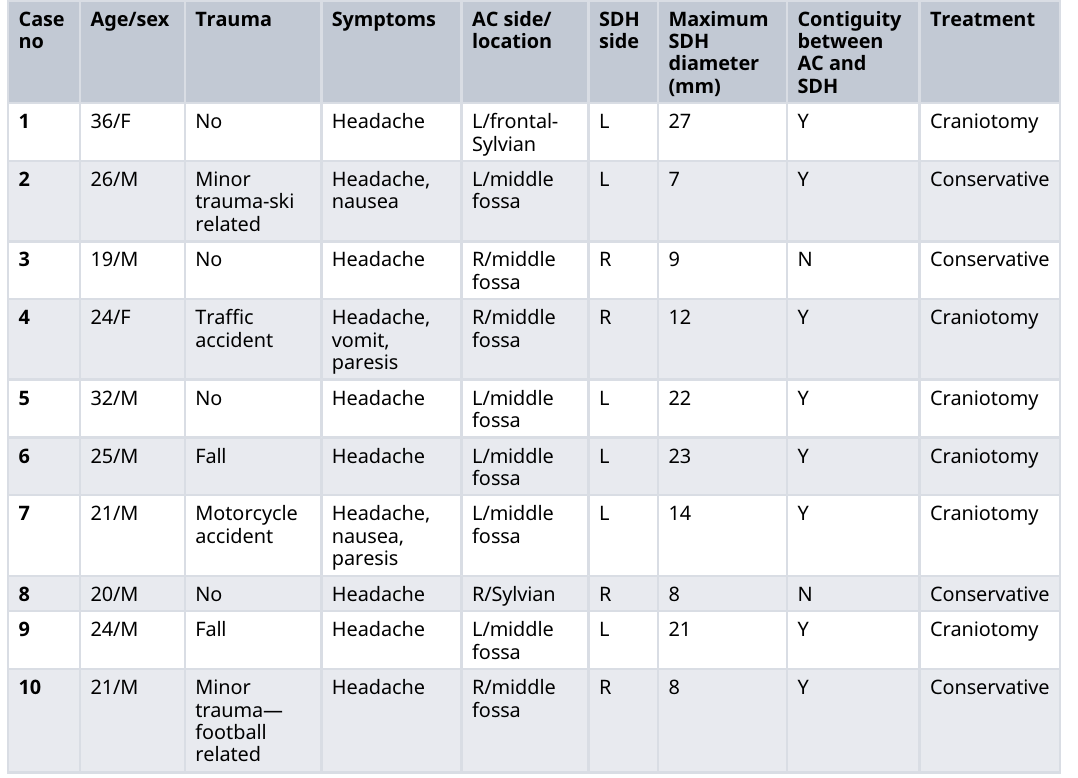
Table 1. Comparison between young adult patients who had chronic subdural hematomas with and without arachnoid